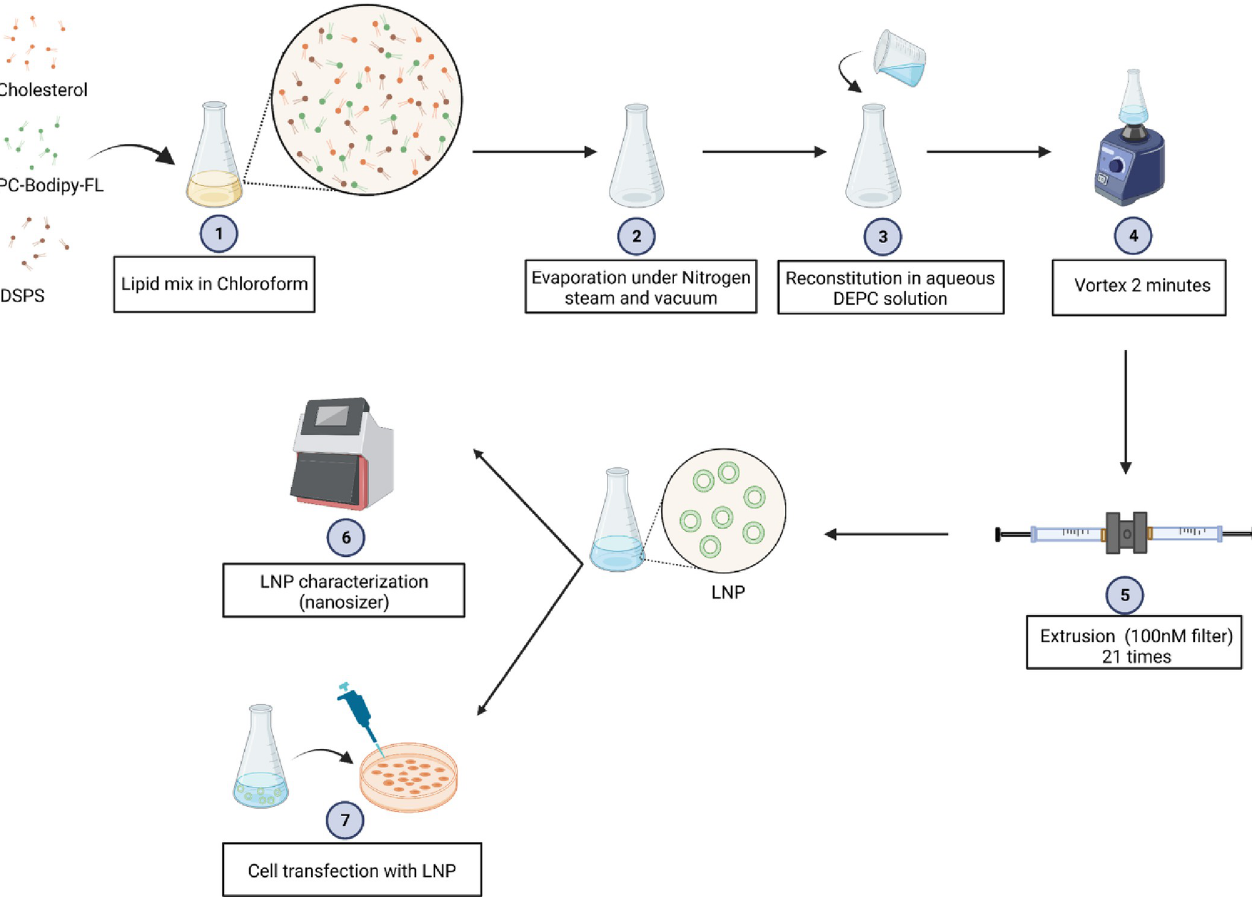
Fig 1. Representation of liposomal nanoparticles (LNP) manufactured. Schematic diagram for the synthesis of DSPS-LNP containing Bodipy-FL with or without cholesterol.